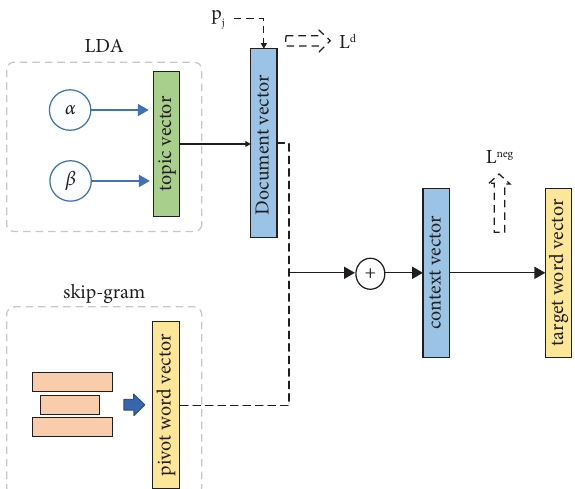
Figure 3: LDA2vec is a combination of LDA and word2vec. Te topic vector is generated from the inverse result of the text generation method based on the Dirichlet distribution parameters α and β . With a membership parameter p j , the topic vector generates the document vector. Te pivot word vector is obtained from skip-gram in word2vec. We combine the two vectors to get the context vector and compare with the target word vector to get an unsupervised learning